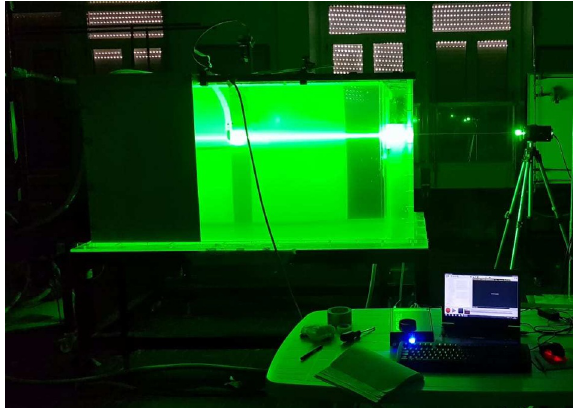
Fig. 4. Experimental